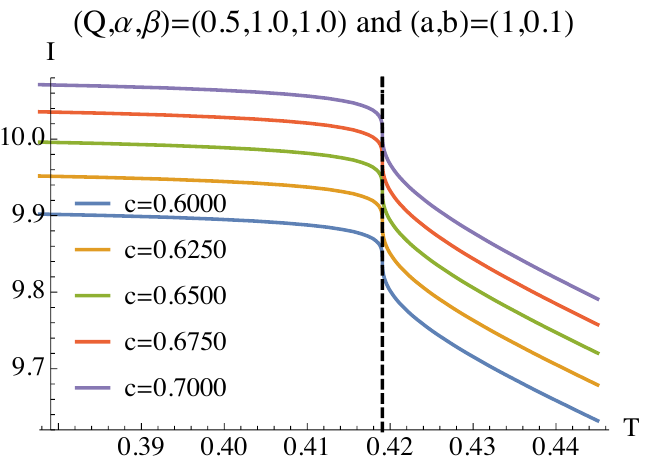
Figure 9 . The T vs. I in the scenario with a second-order phase transition. The red dashed horizontal line represents the critical temperature T c = 0 . 4191 of the second-order phase